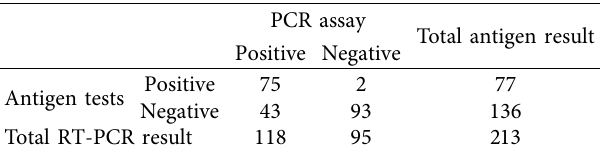
Table 3: Contingency table showing the PCR and antigen test results.